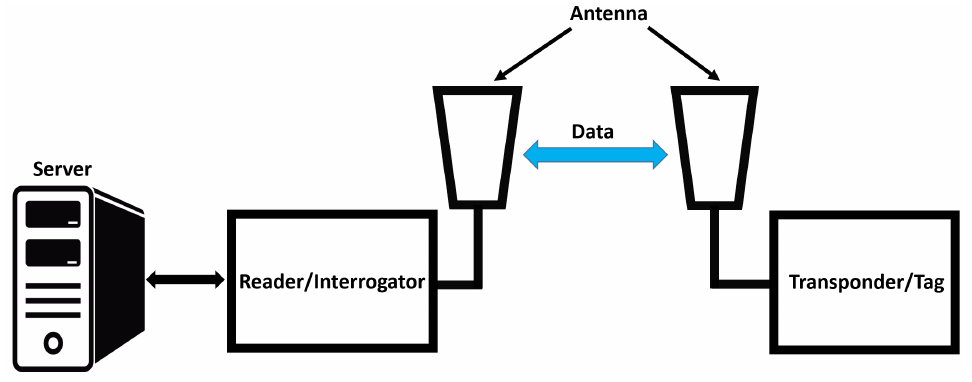
Figure 18. An RFID